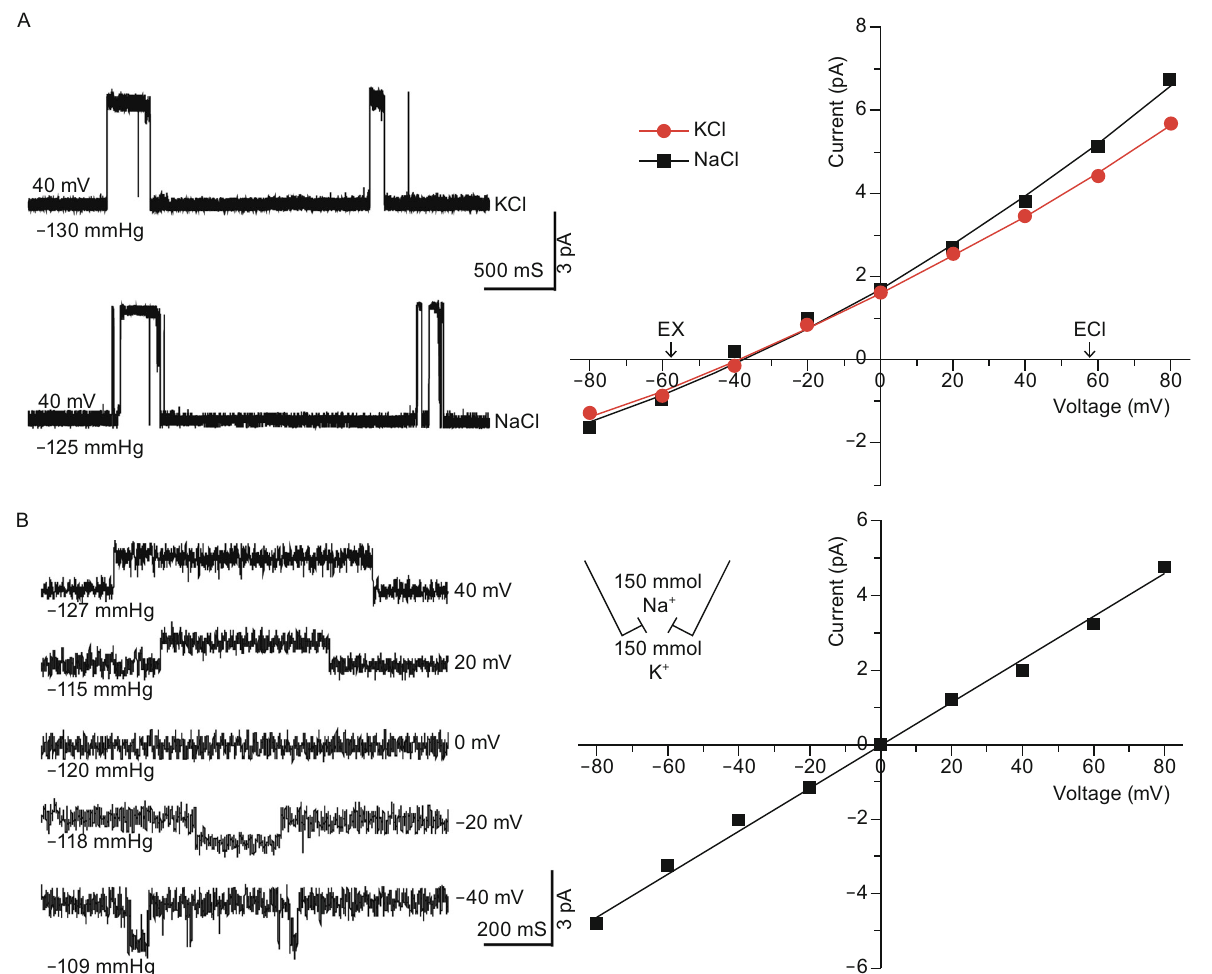
Figure 1. YnaI is a Na + /K + selective mechanosensitive channel. (A) Left: single-channel traces were recorded by patch-clamp system from giant liposomes in KCl solution (upper) or NaCl solution (lower) at +40 mV. YnaI mutants were recorded in only KCl solution by the same method. The numbers under the single-channel traces represent the negative pressure applied to the patch during the event. Right: I – V curves for YnaI channel at a 10:1 salt gradient (150 mmol/L/15 mmol/L, KCl or NaCl); the reversal potentials of an ideal anion or cation-selective channel with Erev = +58 mV or − 58 mVaccording to the Nernst equation are indicated. The reversal potentials for YnaI at KCl or NaCl solution are − 39.2 ± 1.1 mV ( n = 5, mean ± SE) and − 40 ± 1.0 mV ( n = 6, mean ± SE), respectively. (B) Left: single-channel traces of YnaI at different voltages (0 mV, ±20 mV, ±40 mV), with recording solutions fi lled by 150 mmol/L NaCl in the pipette and 150 mmol/L KCl in bath solutions, respectively. Right: I – V curve for YnaI channel at the condition that had described in left panel. The reversal potential was changed to 0 mV under 150 mmol/L NaCl/150 mmol/L KCl